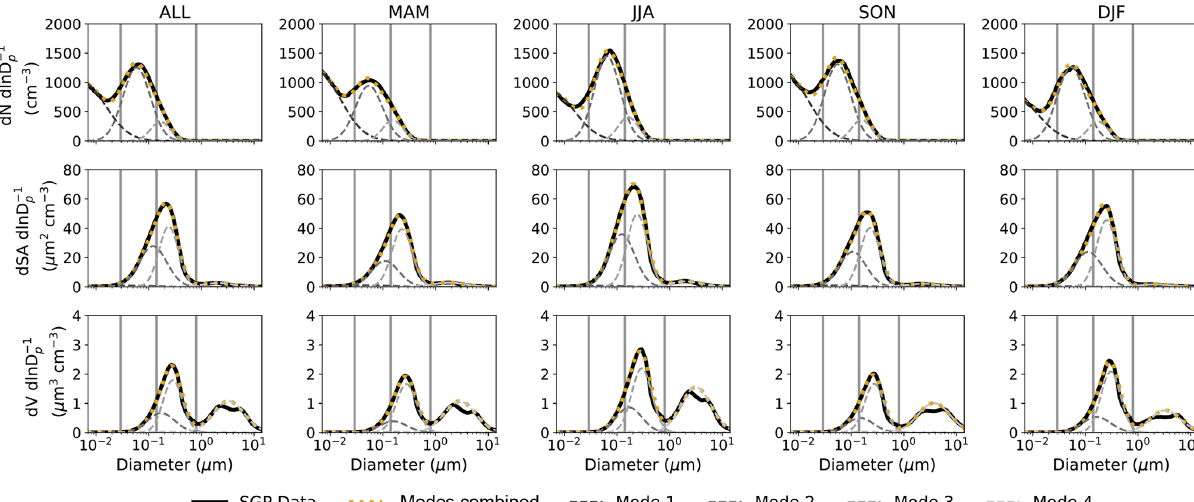
Figure 3. Median distributions from each season (black) fitted with four lognormal distributions (modes). The columns (left to right) represent the time periods ALL, MAM, JJA, SON, and DJF, respectively. The rows (top to bottom) represent the number, surface area, and volume size distributions, respectively. The vertical gray lines demarcate the four separate regions of the size distribution that were used for further analyses in this study.